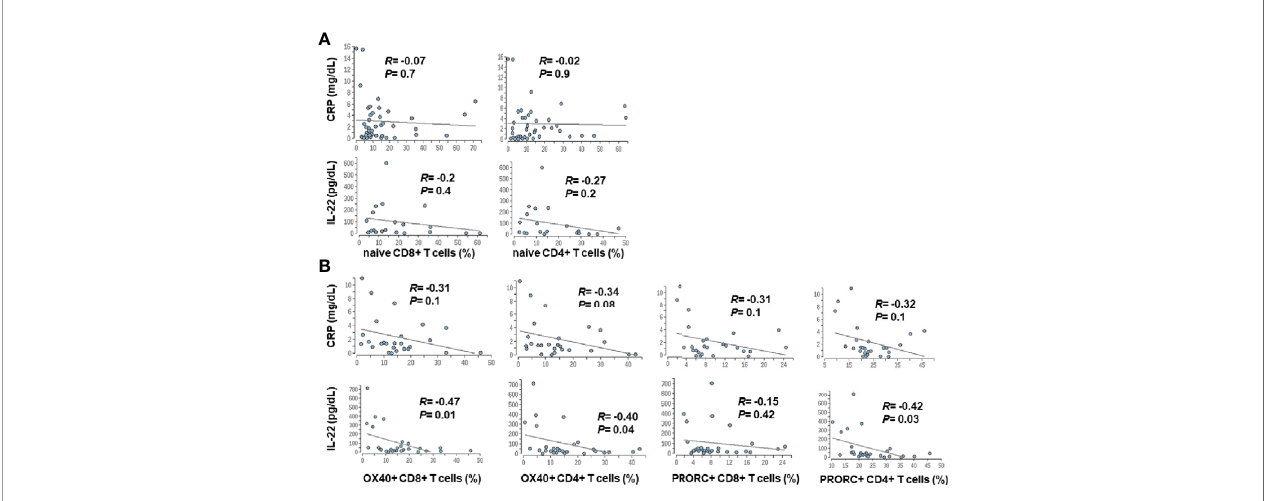
FIGURE 7 | Correlation between markers of systemic in fl ammation and changes in the adaptive immune system in patients with liver cirrhosis. Serum concentrations of CRP and IL-22, which are well established markers of systemic in fl ammation in cirrhosis (9), were correlated with frequencies of naïve CD4+ and CD8+ T cells (A) , was well as with the expression of selected co-stimulatory (OX40) and inhibitory (PRORC) immune checkpoints (B) .